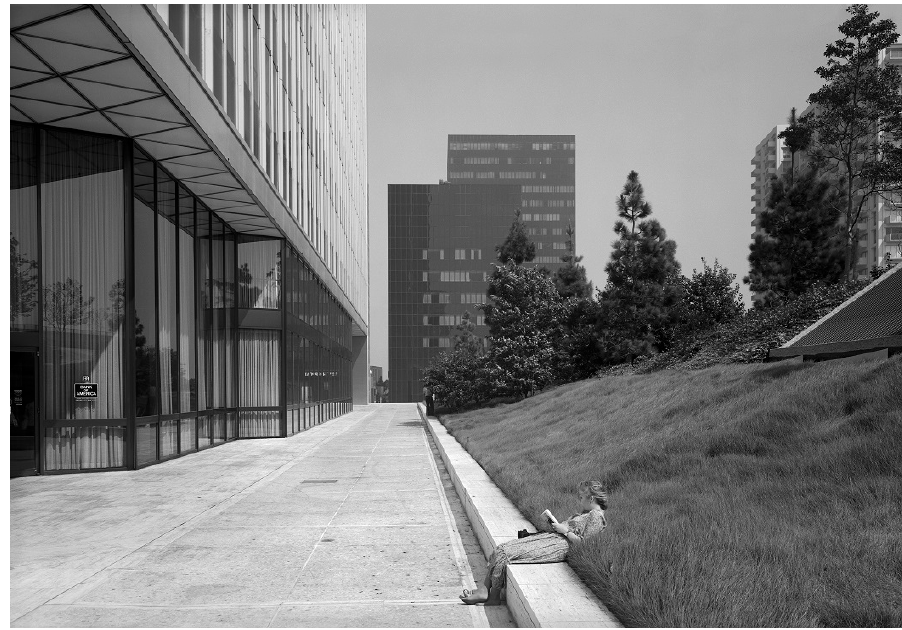
Figure 21. Anthony Hernandez, Public Use Areas # 25 (1980), © Anthony Hernandez.